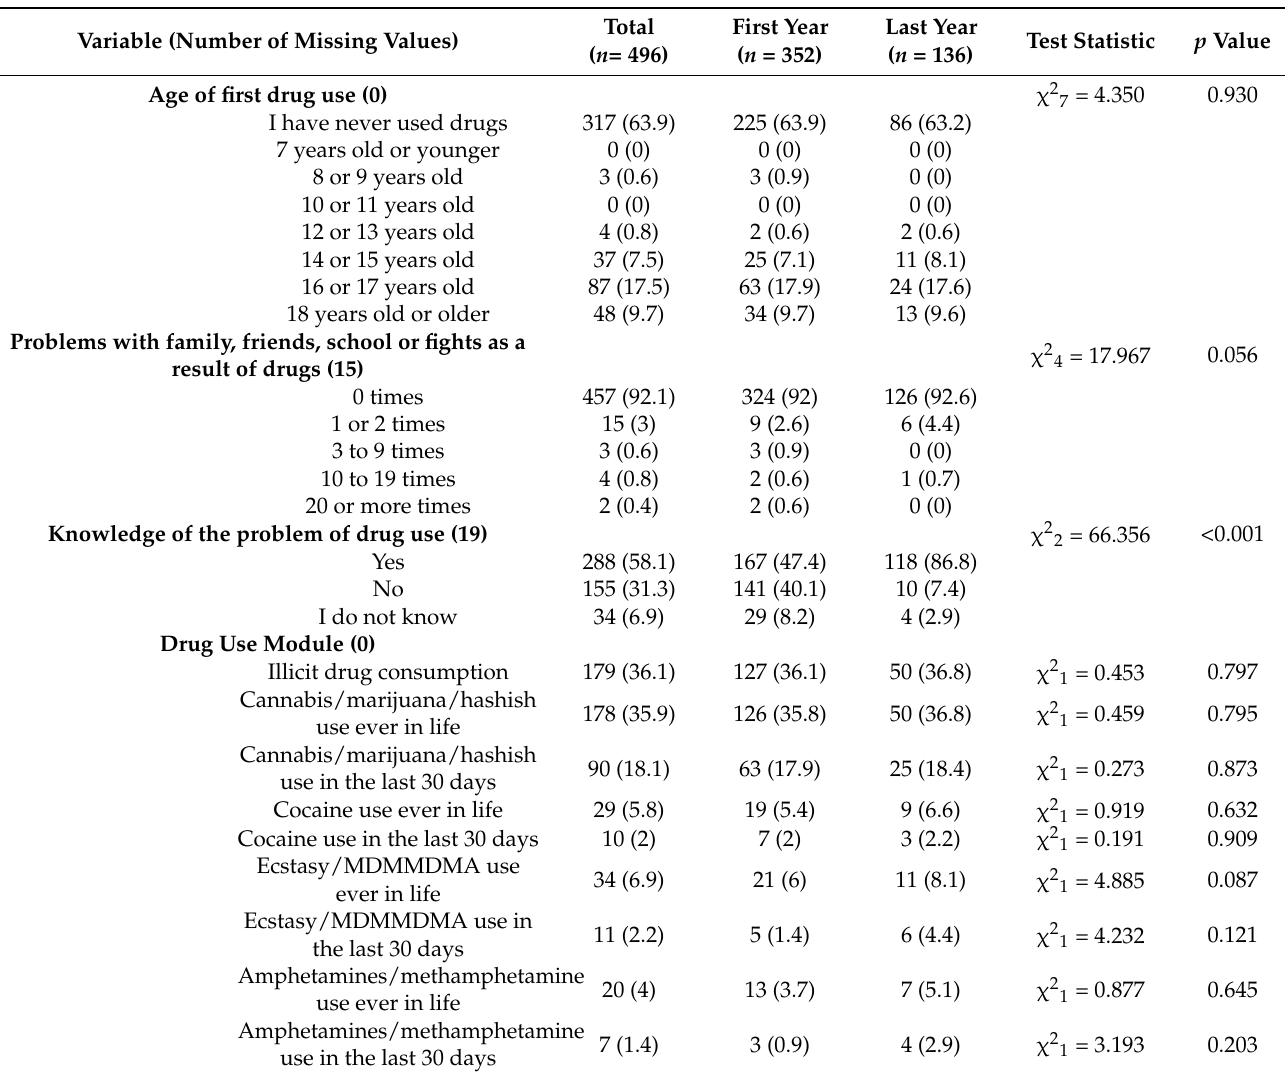
Table 2. Characteristics of participants. Differences by academic